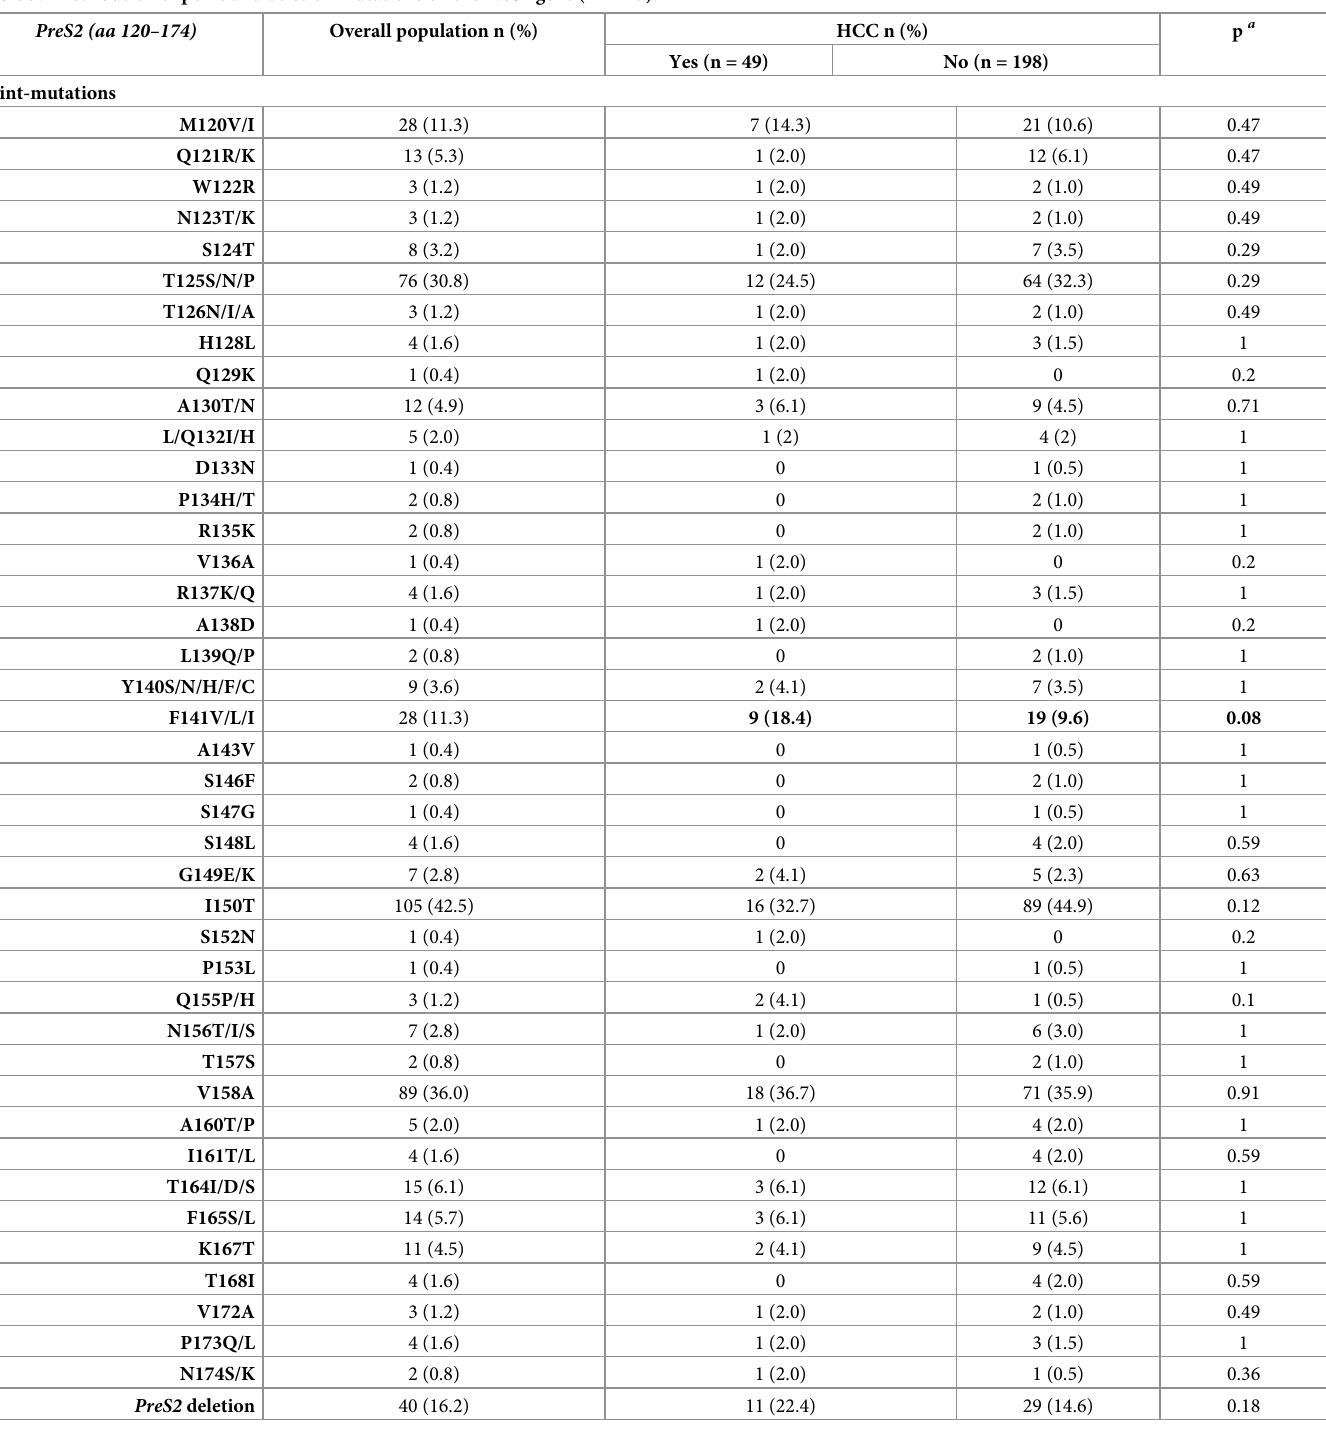
Table 3. Distribution of point and deletion mutations on the PreS2 gene (n = 247). PreS2 (aa 120–174)